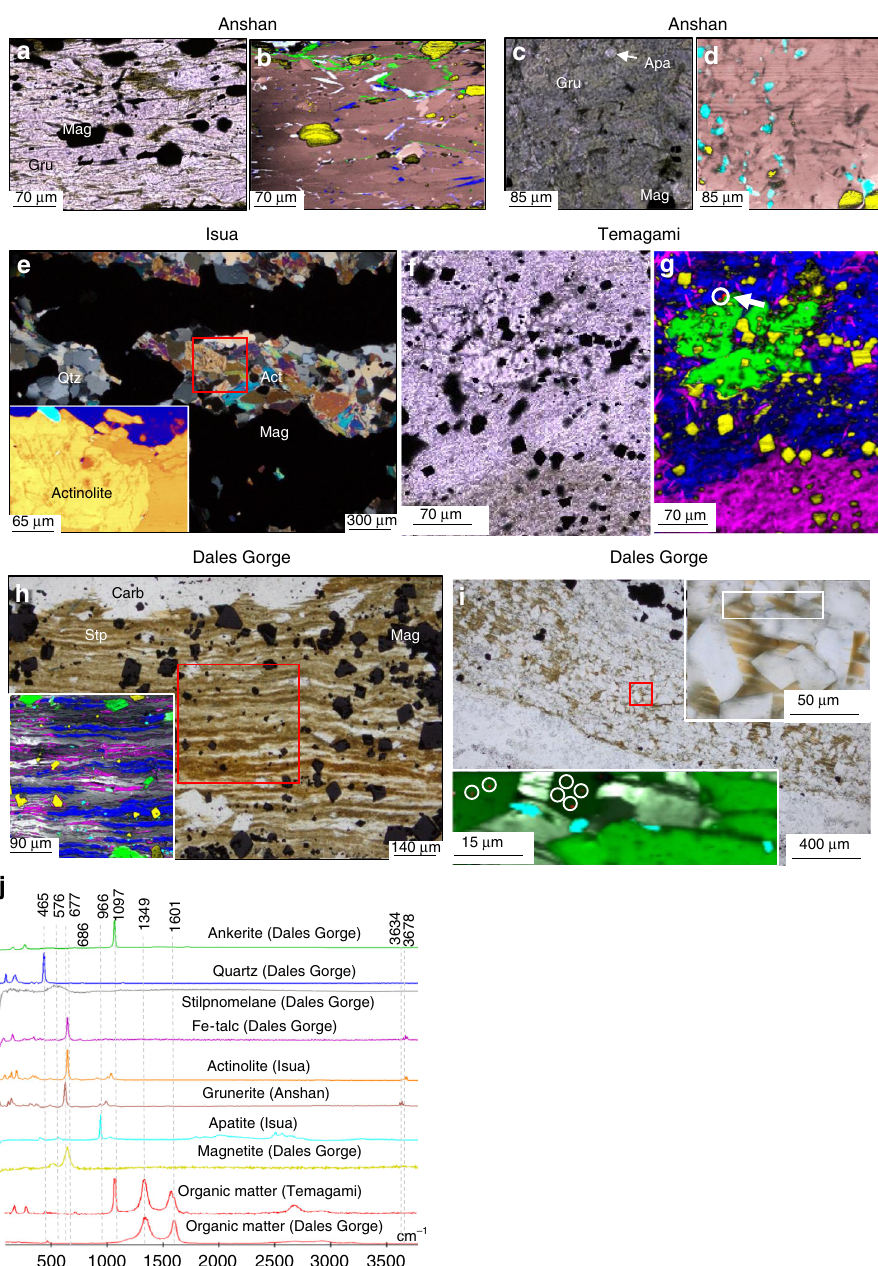
Fig. 4 Iron-clays lacking organic matter in BIF. a TL image of a grunerite layer in the Anshan BIF. b Raman map of A, showing no inclusions within the grunerite, and large grains of magnetite, quartz and ankerite between grunerite. White colours are an artefact from colour mixing. c TL image of grunerite with apatite inclusions in the Anshan BIF. d Raman image of C, showing apatite inclusions in grunerite with no graphite inclusions. e Cross-polar image of grunerite and magnetite layers in the Isua BIF, inset is a Raman image of the boxed area, showing grunerite and apatite with no inclusions of graphite. f TL image of ankerite and Fe-talc in Temagami BIF. g Raman image of ankerite and Fe-talc in panel f , organic matter occurs only with the carbonate (circled). h TL image of fi nely layered stilpnomelane with magnetite, and ankerite overgrowths in the Dales Gorge BIF, inset is a Raman image of the boxed area, showing apatite within and around the stilpnomelane layers, neither the stilpnomelane or apatite have organic matter inclusions. i TL image of laminated stilpnomelane layers, overgrown by siderite rhombohedra. Top right inset is a higher magni fi cation image of the red boxed area, white box in the inset corresponds to the bottom right inset. The bottom left inset is a Raman image showing the occurrence of organic matter (circles) in carbonate, and not stilpnomelane. j Representative Raman spectra for this fi